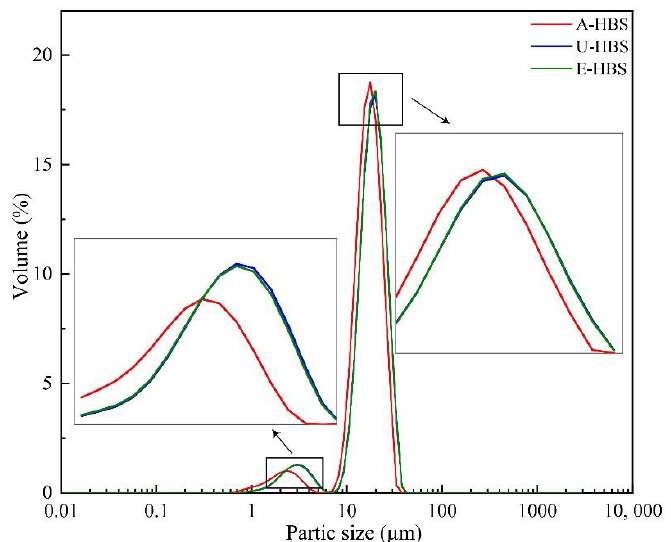
Figure 1. Scanning electron micrographs (SEM) (×500) of highland barley starch samples. A-HBS: HBS extracted by alkali method; U-HBS: HBS extracted by ultrasonic method; E-HBS: HBS extracted by enzymatic method.